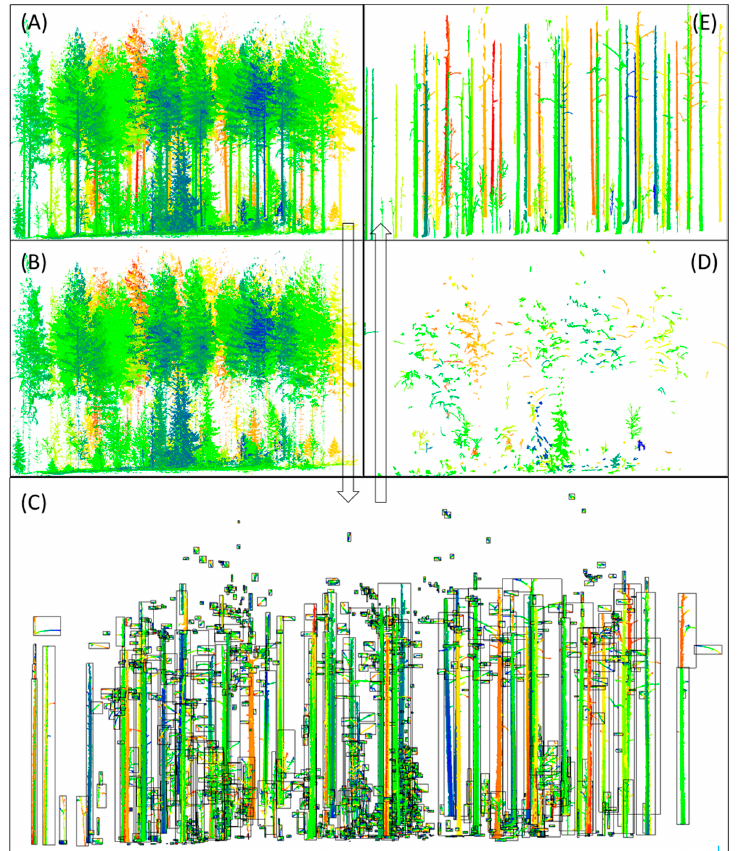
Figure 7. Flowchart of the stem point extraction based on connected component (CC) segmentation, taking the multi-scan dataset of the plot 1 as an example. ( A ) The preprocessed point cloud after ground filtering, and branch and foliage thinning. The following CC segmentation was implemented based on it. ( B ) The removed small segments that the number of points (NoP) per segment less than the threshold. ( C ) The high-probability stem segments with a NoP per segment larger than the threshold. ( D ) The removed segments with a height-to-width ratio less than the threshold. ( E ) The finally detected stem points by the CC segmentation method. In (A), (B), (D), and (E), the colors were randomly assigned to the points according to their X coordinate. In (C), the colors were randomly assigned to each segment, and the black boxes were the boundaries of each segment.